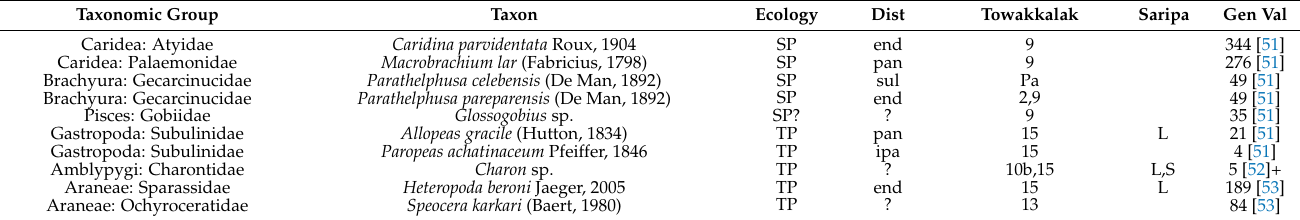
Table 2. Main stygophilic and troglophilic species of the Towakkalak and Saripa systems. Abbreviations: Ecology: SP, stygophile (aquatic); TP, troglophile (terrestrial); Gu: guanophile (terrestrial); eu, euedaphic (terrestrial). Distribution (dist): cos, cosmopolite; end, restricted to the Maros karst; ipa, Indo-Pacific; pan, pantropical; sul, Sulawesi; wid, widespread. Towakkalak: see Figure 3 for cave numbering; 10b, Gua Uri; 12b, Gua Bantimurung; Pa, Lubang Pangni. Saripa: same as Table 1. Number of species in the genus and taxonomic validity of the species (gen val): same as Table 1. Taxonomic